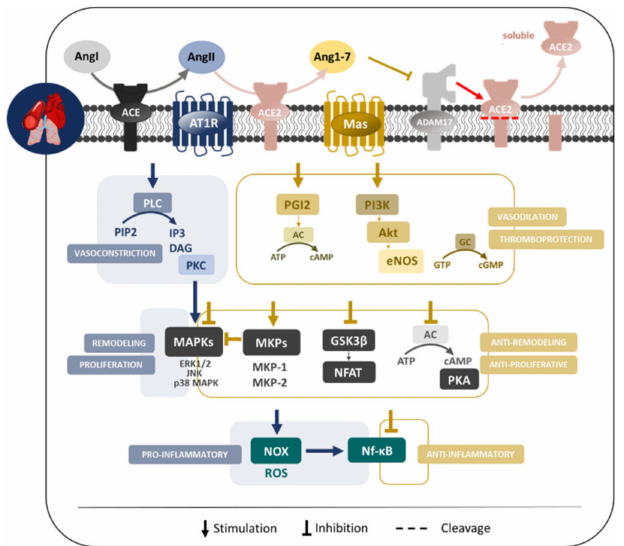
Figure 2. Selected molecular pathways affected by ACE2/Ang(1-7)/Mas axis in cardiovascular and pulmonary